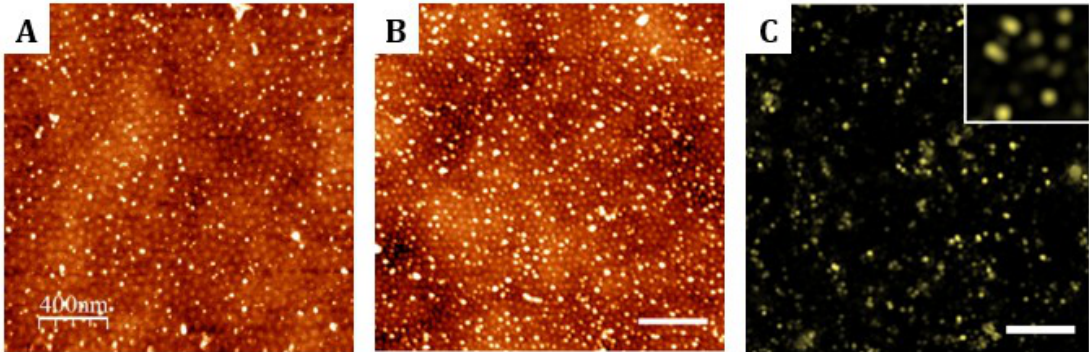
Figure 4. ( A ) AFM images of the topography of thin films of PS-b-PMMA 123-35 diblock copolymer after 0.5 h of hydrolysis and ( B ) after 1 h of hydrolysis and functionalization with Alexa Fluor ® 647 hydrazide fluorescent dye. Scale bar 400 nm; Z-scale: 5 nm. ( C ) Direct stochastic optical reconstruction microscopy (dSTORM) image showing the surface distribution of the from the Alexa Fluor ® 647 hydrazide dye fluorescence. Inset shows the clusters of the dye following the underneath nanostructured template. Scale bar 400 nm.